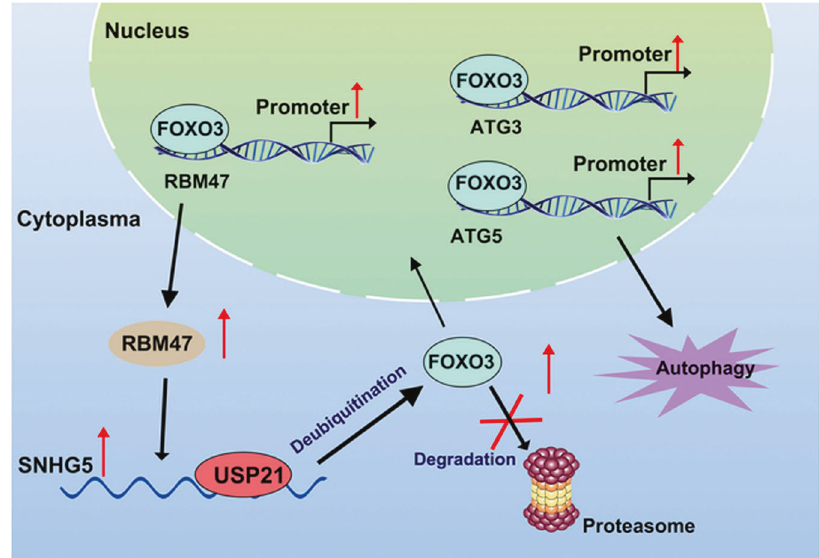
Fig. 8 The regulation mechanism of RBM47/SNHG5/USP21/FOXO3 axis in PTC cells. In brief, the upregulation of RBM47 inhibits PTC cell proliferation and active autophagy by binding to SNHG5. SNHG5 can recruited USP21, which interacts with FOXO3 to inhibit its ubiquitination and further promote its nuclear translocation. FOXO3 activates autophagy by promoting ATG3 and ATG5 transcription and activates RBM47 transcription to form a positive feedback